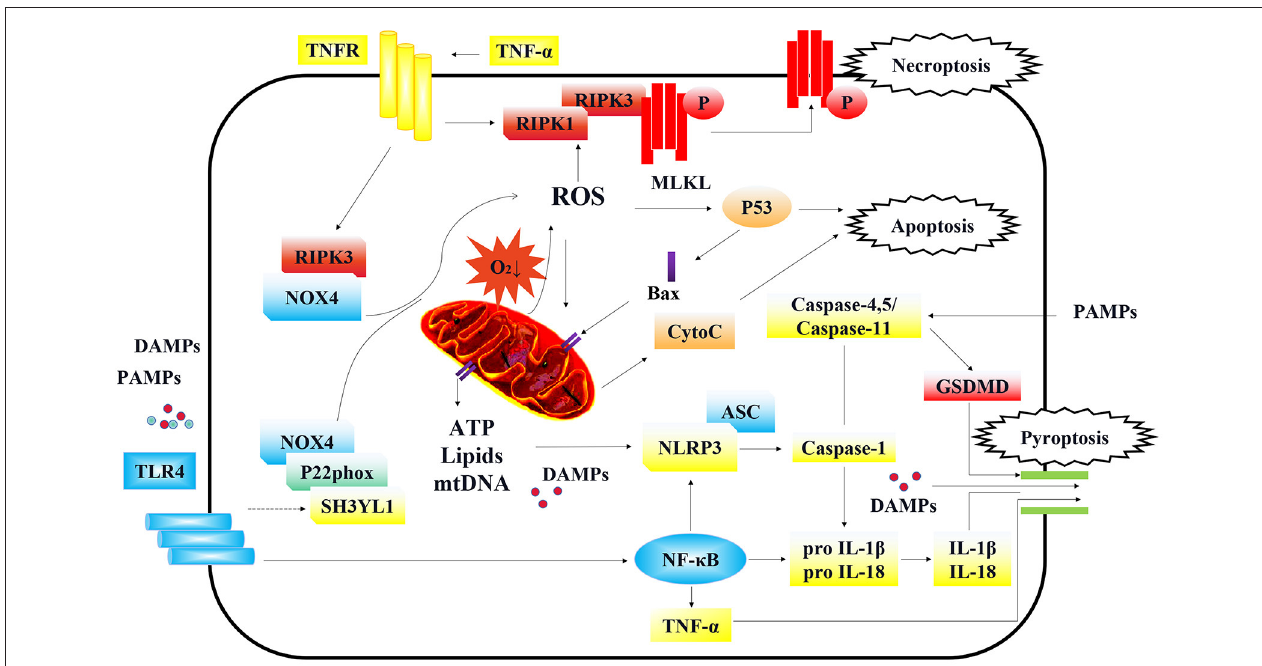
FIGURE 2 | Cellular signaling in regulating programmed cell death of TECs. Under the stimulation of DAMPs/PAMPs, TLR4 is activated and initiates the downstream NOX4 signal. The enhanced connection between SH3YL1 and the anchoring protein P22phox of NOX4, stabilizes and activate NOX4, leading to the production of ROS and further mitochondrial injury. Furthermore, RIPK3 can also directly bind and stabilize NOX4 and bring it to mitochondria, causing mitochondria dysfunction. On the other hand, ROS and activated TNFR are the main inducements of necroptosis. In an oxygen-deficient environment, mitochondria dysfunction can lead to the production of ROS, which activates p53 and causes apoptosis. On the contrary, p53 further activates the formation of Bax dimers which are translocated to the outer membrane of mitochondria leading to the release of mitochondrial cyto C and other potential proinflammatory substances including membrane lipids, ATP, and oxidized form of mtDNA. The substance leaked from mitochondria, triggered the assembly and activation of the NLRP3 inflammasome, causing cell pyroptosis. Besides, NLRP3 can also be activated by the PAMPs entered through endocytosis. NLRP3 captured adaption protein ASC and further activated caspase-1 that led to maturation of inflammatory factors IL-18 and IL-1 β and the cleavage of GSDMD. Moreover, TLR4 can activate the NF- κ B signaling pathway which transcriptionally regulates the production of TNF- α , IL-1 β , IL-18, and NLRP3. Caspase-11 in mice and its homologs in humans (caspase-4/5) can be directly activated by PAMPs, independent of NLRP3 activation. Finally, the cleaved GSDMD by caspase-1 formed the structure of membrane pores, leading to the release of pro-inflammatory cytokines, damage associated molecular patterns (DAMPs) and other cellular contents. After releasing to the extracellular environment, DAMPs and pro-inflammatory cytokines further aggravated the necroptosis and pyroptosis, in